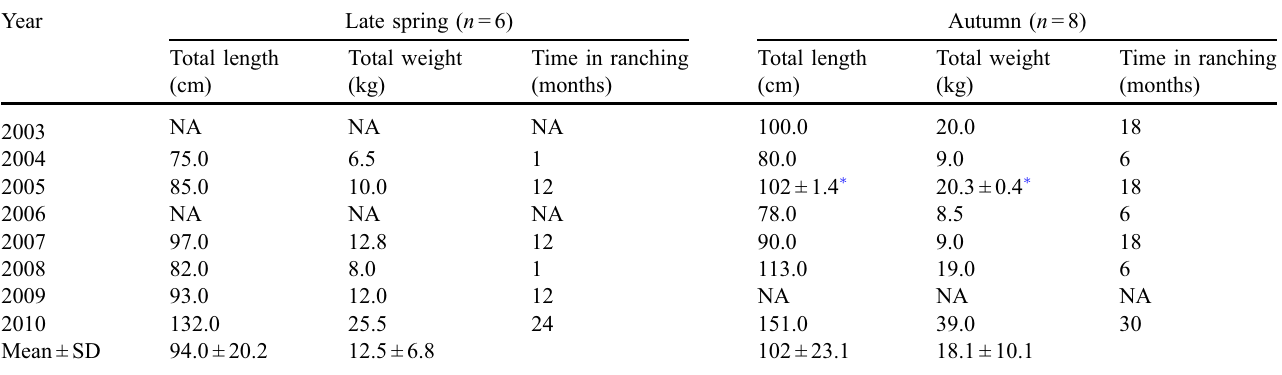
Table 1. Total length and weight of Atlantic blue fi n tuna ( Thunnus thynnus ) on the study farm, 2003 –